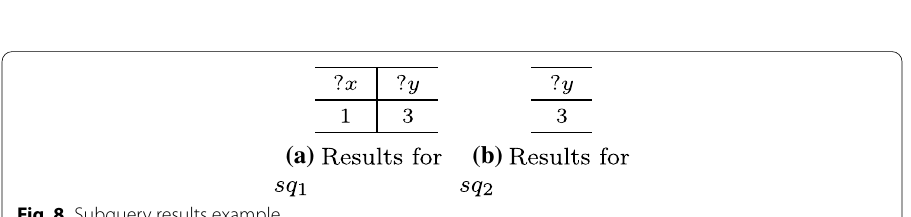
Fig. 8 Subquery results